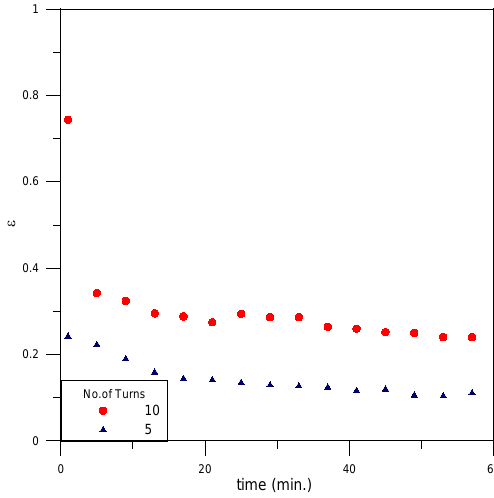
Figure 7. Effect of coil loops on the